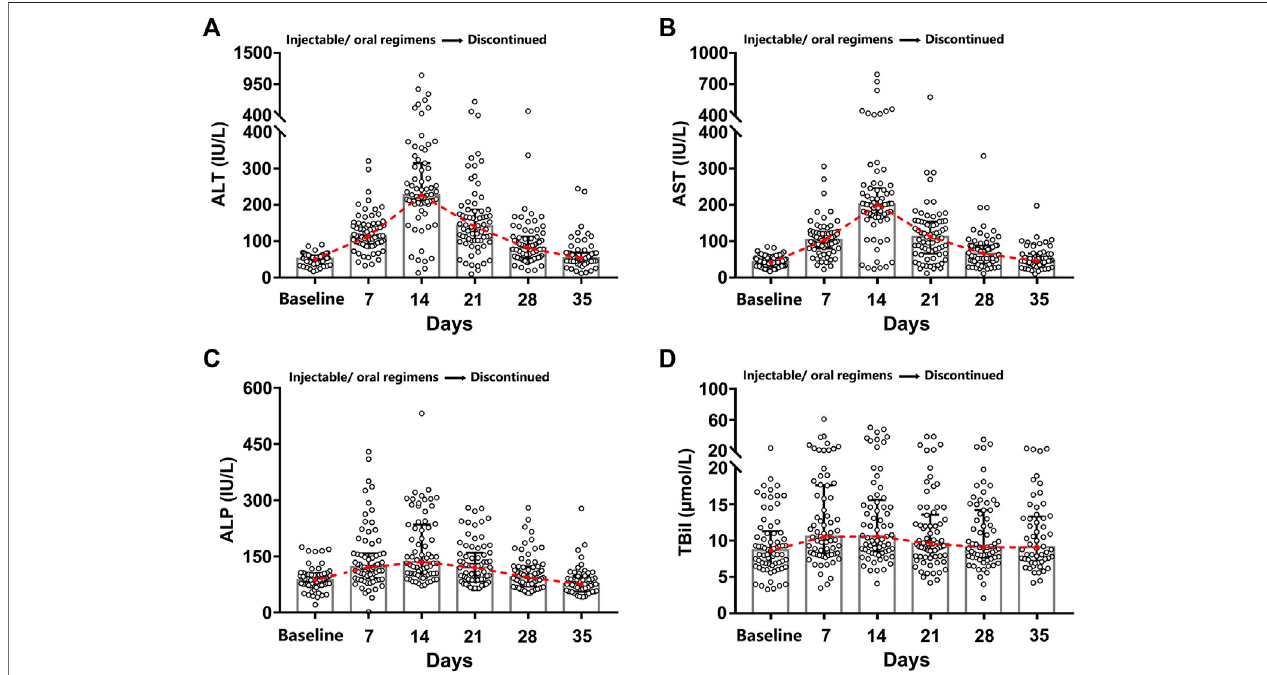
FIGURE 2 | Dynamic hepatic function indexes diagram. The treatment (injectable/oral regimens) was immediately discontinued for one to three weeks once abnormal liver function appeared. Four main hepatic function indexes (ALT (A) , AST (B) , ALP (C) , and TBil (D) ) were recorded for the 71 DILI patients before and after brucellosis-speci fi c